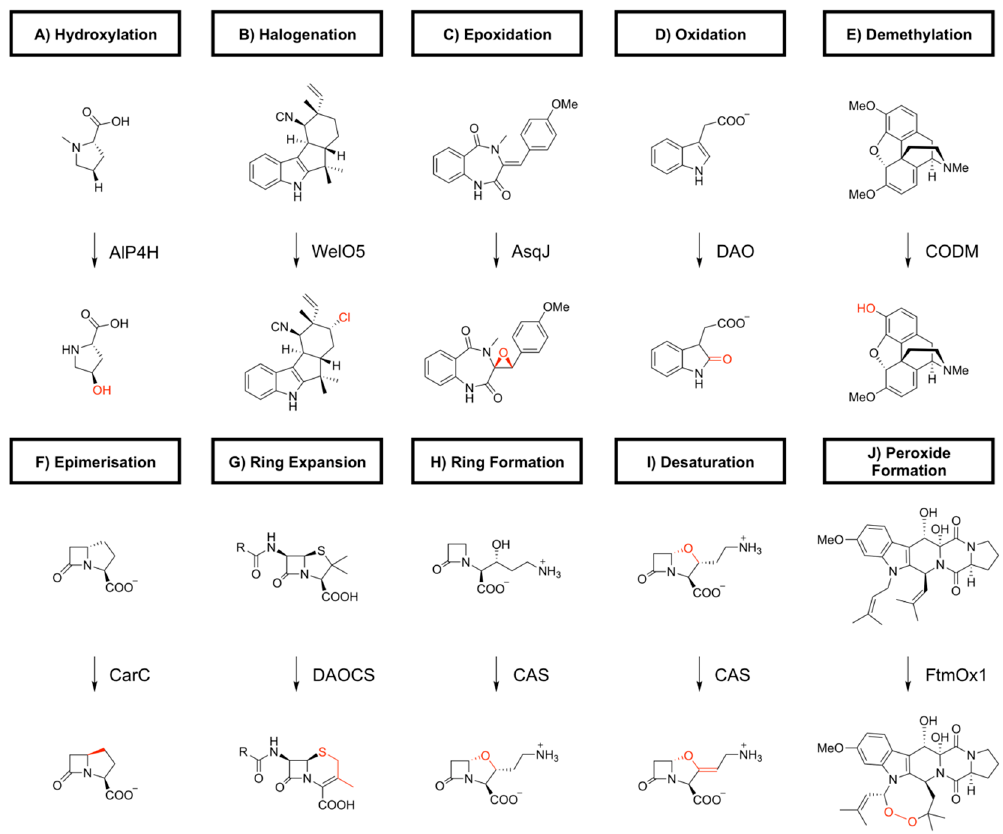
Figure 1. Examples of 2-oxoglutarate-dependent oxygenase-catalyzed reactions by representative members of this enzyme family. ( A ) Hydroxylation of proline by L -proline hydroxylase AlP4H to form trans -4-hydroxy- L -proline [29]; ( B ) Halogenation of 12- epi -Fischerindole U by WelO5 to yield 12- epi -Fischerindole G [30]; ( C ) Epoxidation of 4 (cid:48) -methoxyldehydroxy cyclopeptin by AsqJ to form 4 (cid:48) -methoxylcyclopenin [31,32]; ( D ) Oxidation of a tryptophan derivative by dioxygenase for auxinoxidation (DAO) to form the plant auxin indole-3-acetic acid [33–35]; ( E ) O -demethylation of thebaine in morphinan alkaloid biosynthesis by codeine O -demethylase (CODM) [36]; ( F ) Epimerization reaction in the carbapenem core structure maturation as catalyzed by CarC [37,38]; ( G ) Ring expansion reaction of the penicillin N amide thiazolidine ring catalyzed by deacetoxycephalosporin C synthase (DAOCS) [39]; ( H , I ) Ring formation and desaturation reaction in the biosynthesis of clavulanic acid catalyzed by trifunctional 2-oxoglutarate-dependent clavaminate synthase (CAS) [40]; ( J ) Formation of an endoperoxide by FtmOx1 in verruculogen biosynthesis [41,42] .